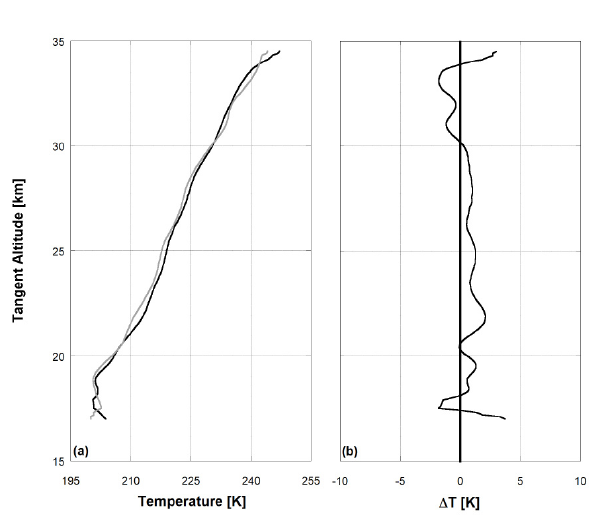
Figure 3. Same as Figure 2, but after removal of wavy structures.